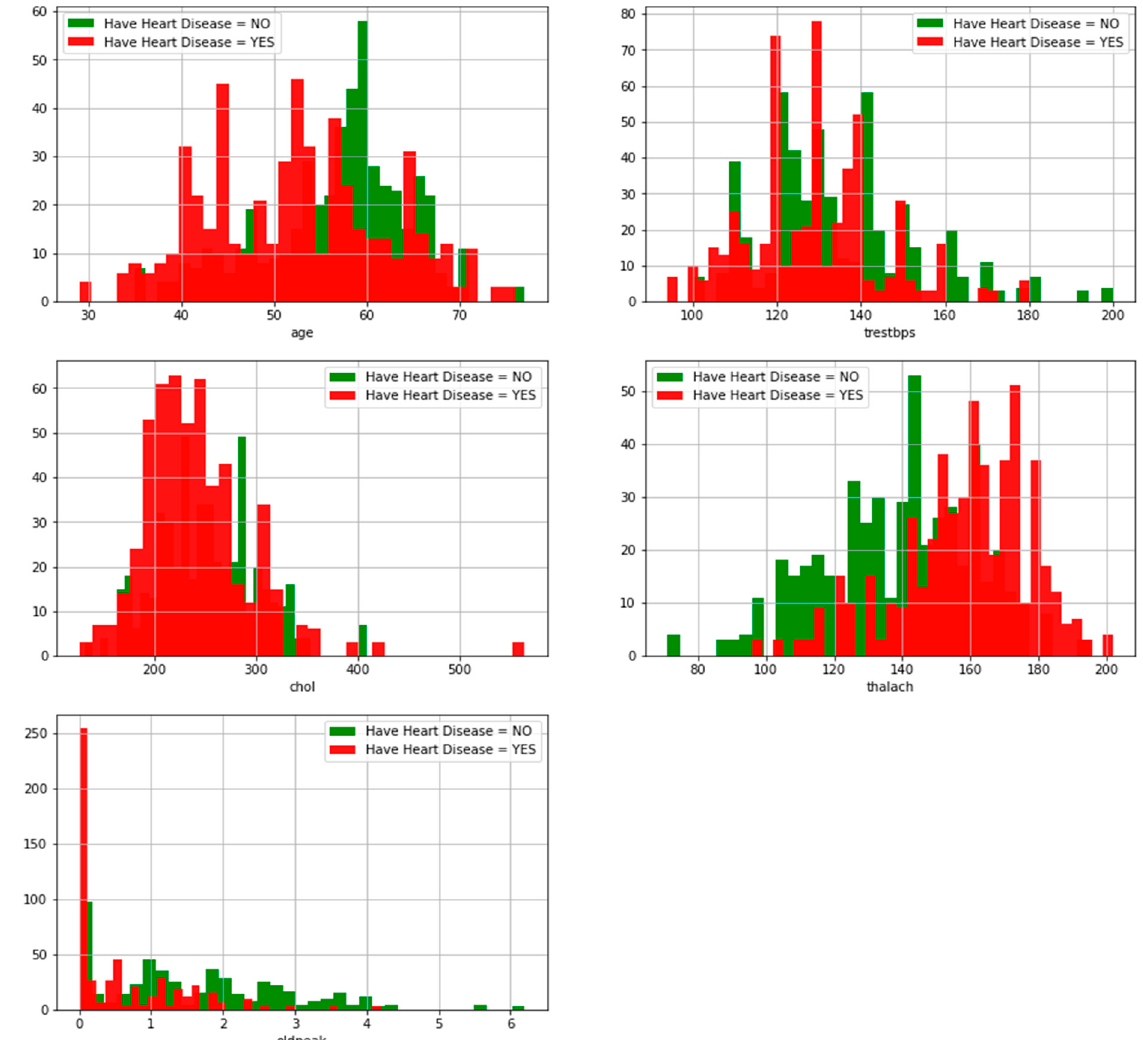
Figure 4. The histograms of continuous-valued attributes.